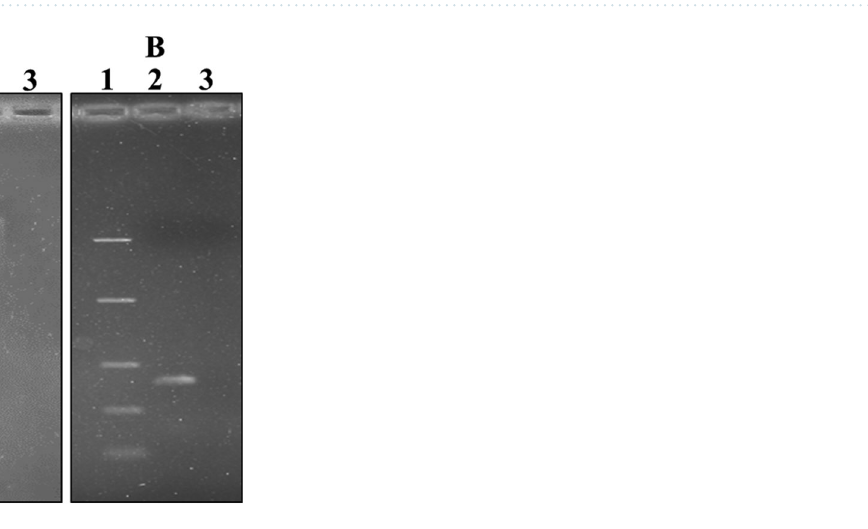
Figure 7. Gel electrophoresis image of ZF 52 genomic DNA. A1—Mid-range molecular weight marker, A2— ZF52 DNA, A3—negative control, B1—Mid-range molecular weight marker, B2—PCR amplification product, B3—negative